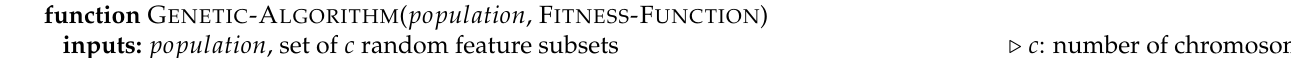
Algorithm 1 Embedded Feature Subset Optimization